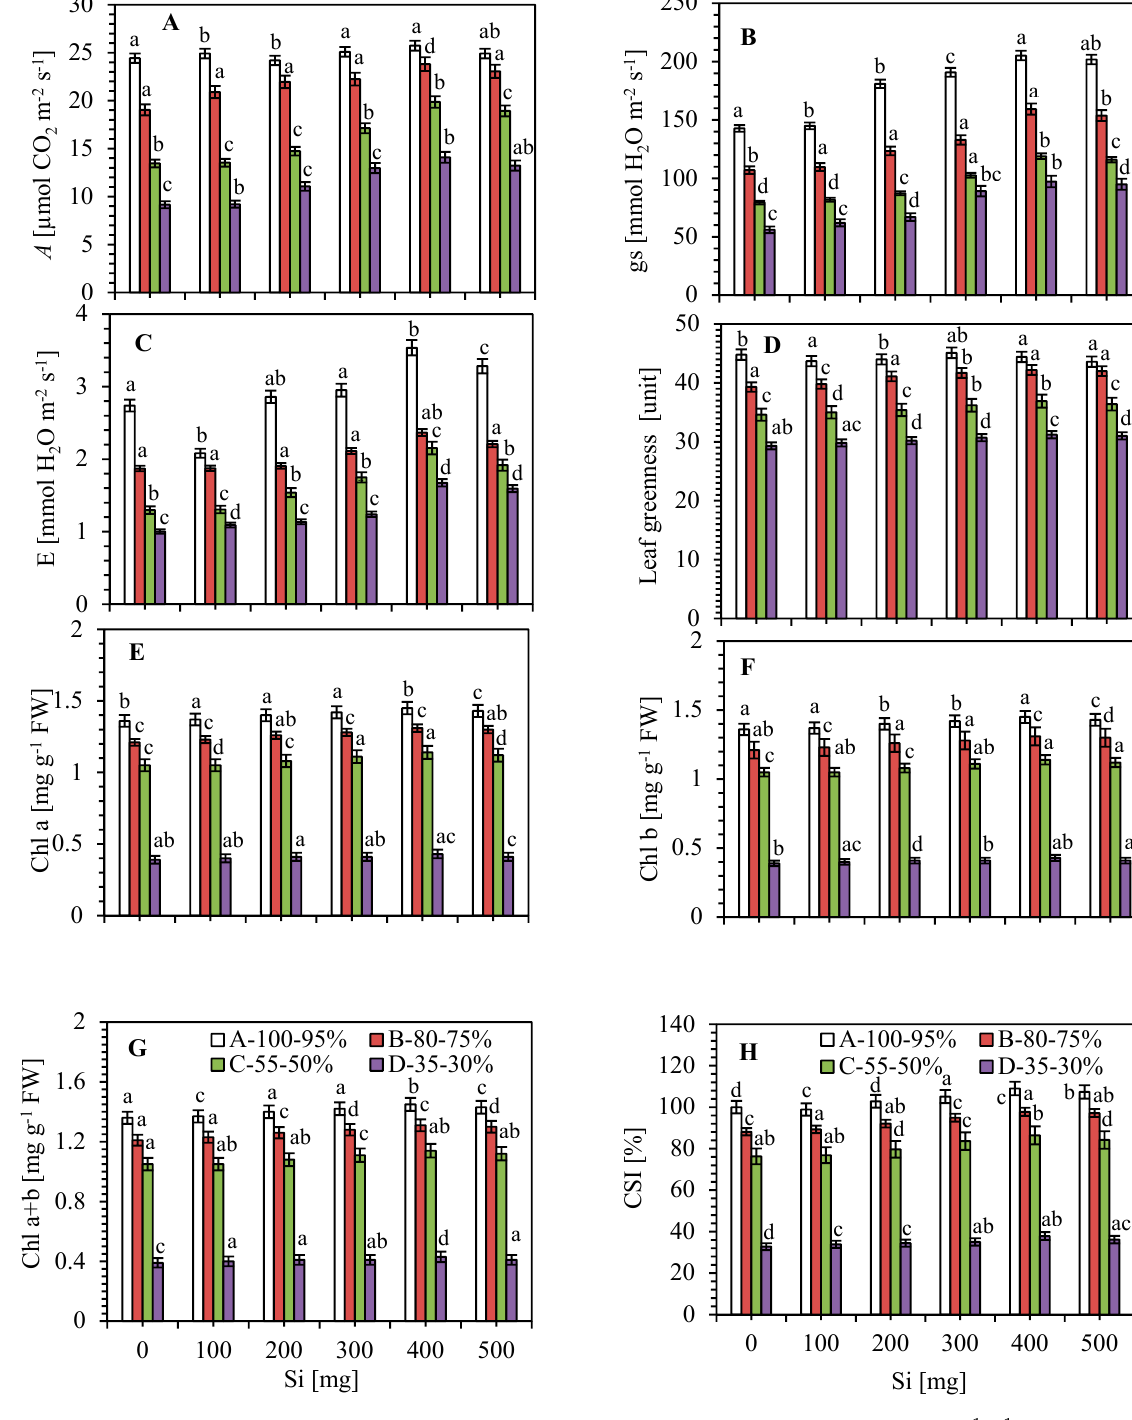
Figure 2. Changes of ( A ) net photosynthetic CO 2 assimilation rate ( A ; µmol CO 2 m − 1 s − 1 ), ( B ) stomatal conductance ( gs ; mmol H 2 O m − 2 s − 1 ), ( C ) transpiration rate ( E ; mmol H 2 O m − 2 s − 1 ), ( D ) leaf greenness—SPAD value (units), ( E – G ) photosynthetic pigments (Chl; mg g − 1 FW) and ( H ) chlorophyll stability index (CSI; %) after silicon application (0, 100, 200, 300, 400 and 500 mg L − 1 ) against normal (100–95%) and limited water irrigations such as 80–75, 55–50 and 35–30% of soil moisture in sugarcane plants. Bar indicates ± SD ( n = 5). Different letters represent significant differences at p < 0.05 level.